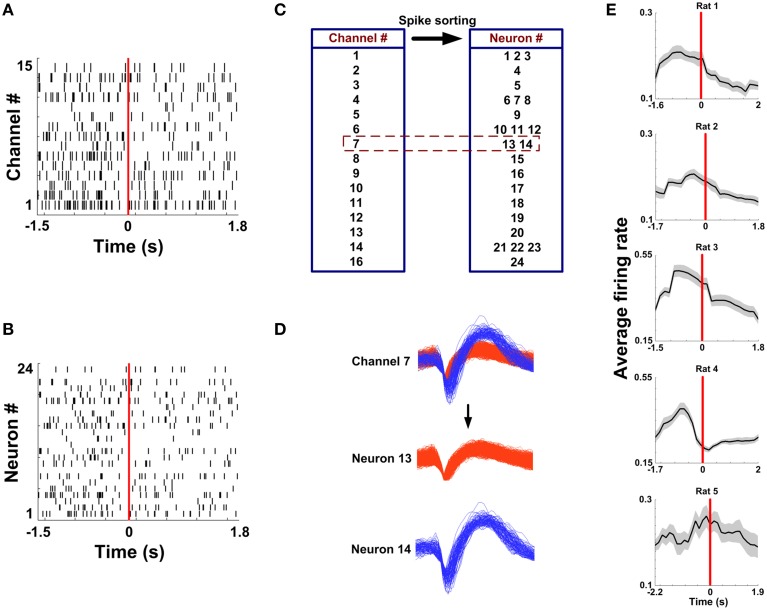
Multi-channel spike sorting. (A) Multi-unit spike trains from 15 channels during a correct trial. Time 0 (red vertical line) indicates the RT. (B) Single-unit spike trains sorted from the recordings in (A). (C) A corresponding relationship between the electrode number and the neuron number. (D) Two neurons were isolated from the Channel 7. (E) Average firing rate as a function of time in correct trials for 5 rats (nRat1 = 20 trials, nRat2 = 13 trials, nRat3 = 18 trials, nRat 4 = 27 trials, nRat5 = 18 trials).